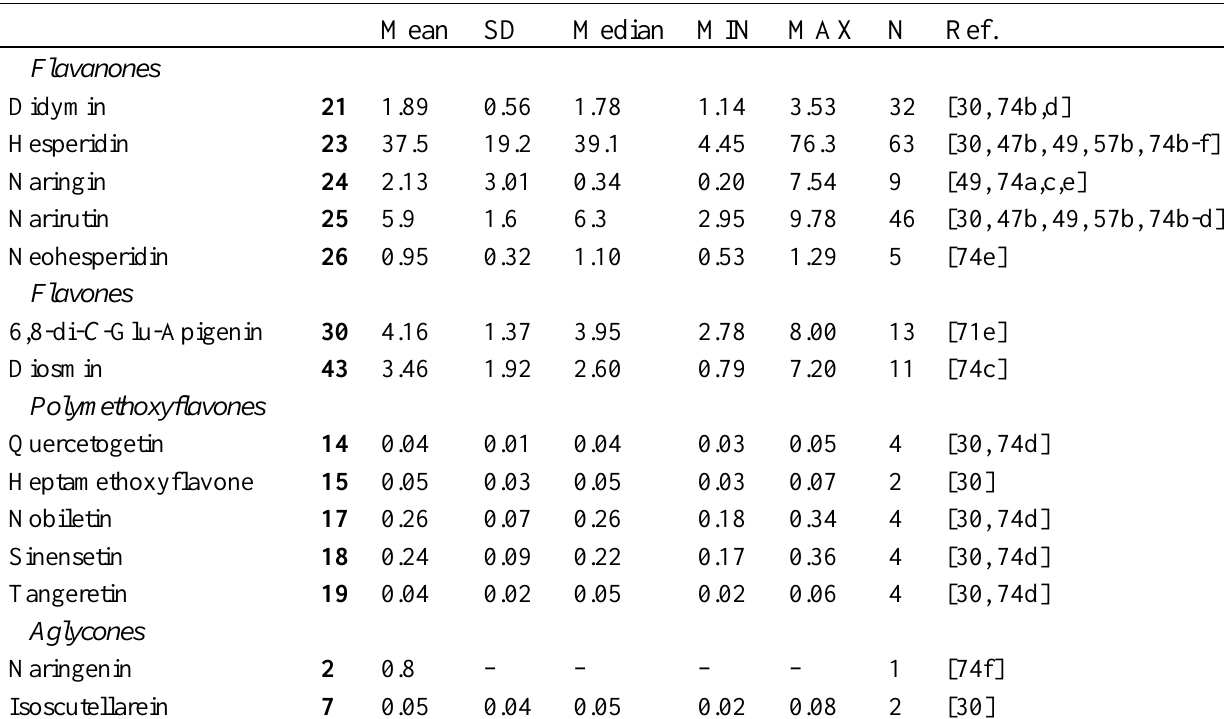
Table 7 . Flavonoid composition of commercial sweet orange juice (mg/100